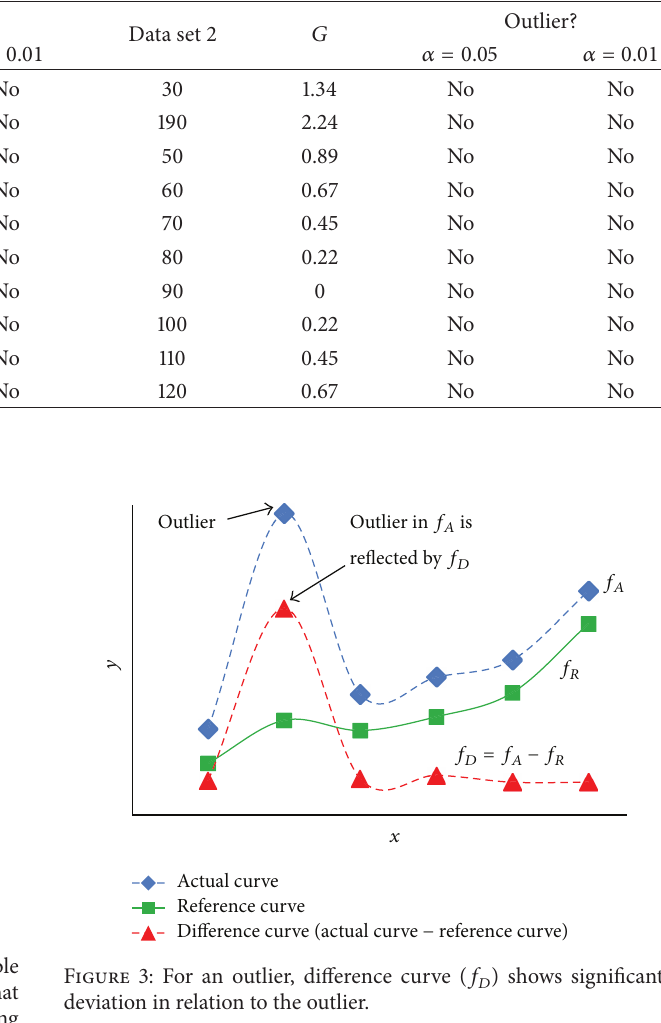
Table 1: Results of Grubbs’ test (two-sided) for data set 1 and data set 2 for significance levels ( 𝛼 ) of 0.05 (critical value of 𝐺 = 2.29 ) and 𝛼 = 0.01 ( 𝐺 = 2.48).